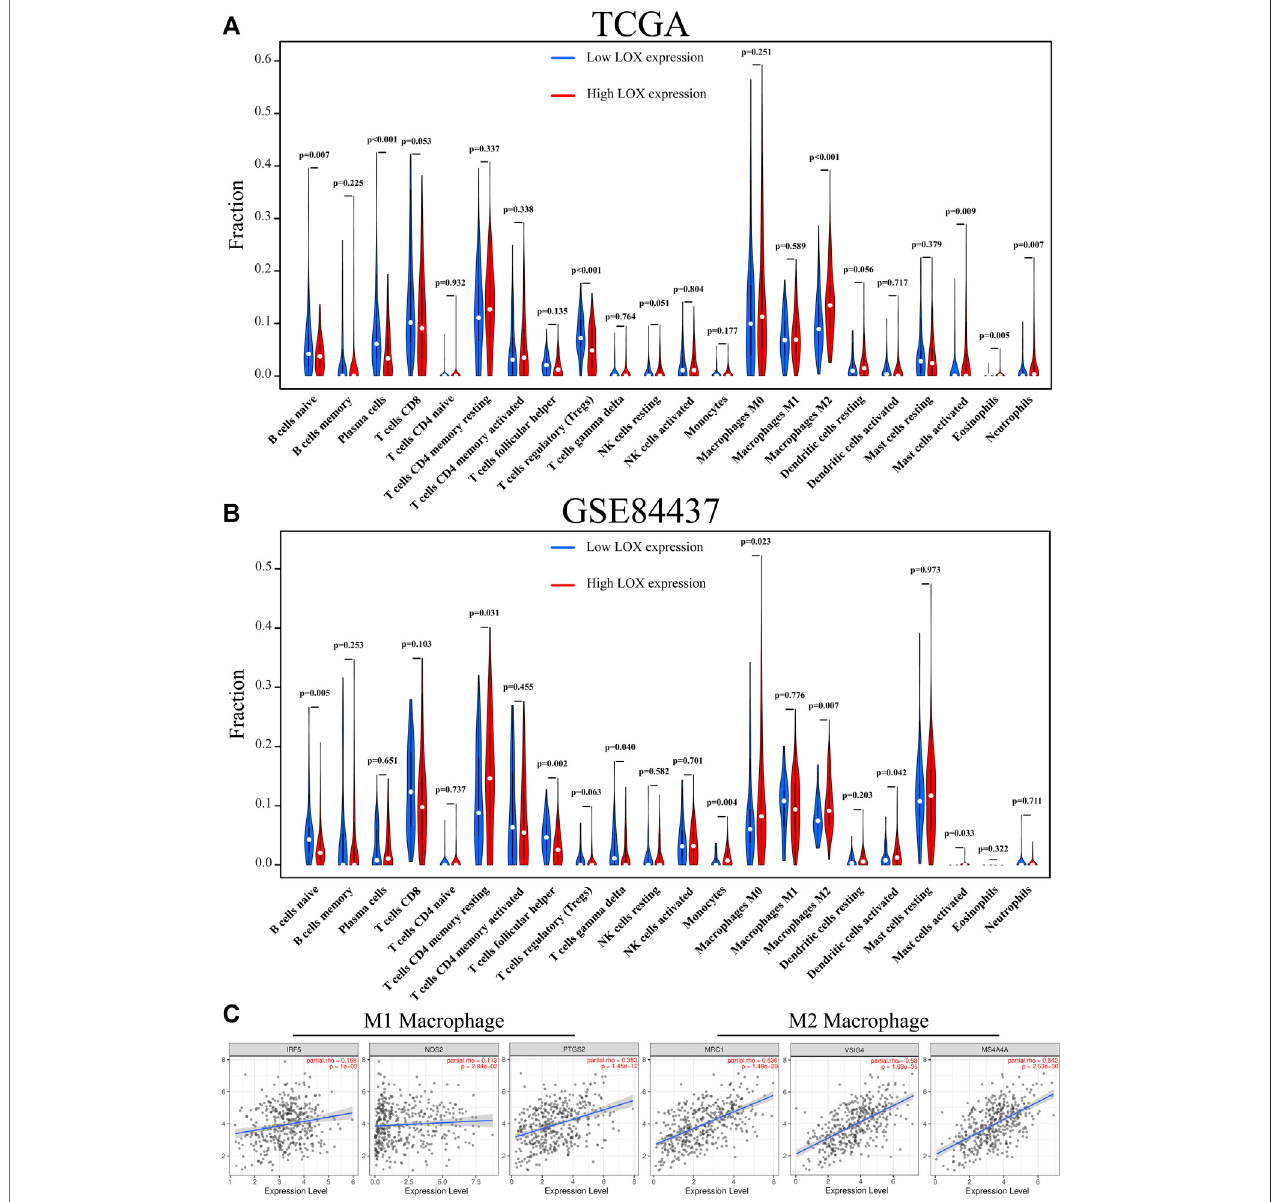
FIGURE 6 | The overexpression of LOX can promote macrophage polarization towards M2 phenotype. (A) Proportions of the 22 tumor-in fi ltrating immune cell typesinthehigh-andlow-LOX-expressiongroupsinTCGAdatabase. (B) Proportionsofthe22tumor-in fi ltratingimmunecelltypesinthehigh-andlow-LOX-expression groups in GSE84437 database. (C) The correlation between LOX expression and markers of M1 and M2 macrophages.